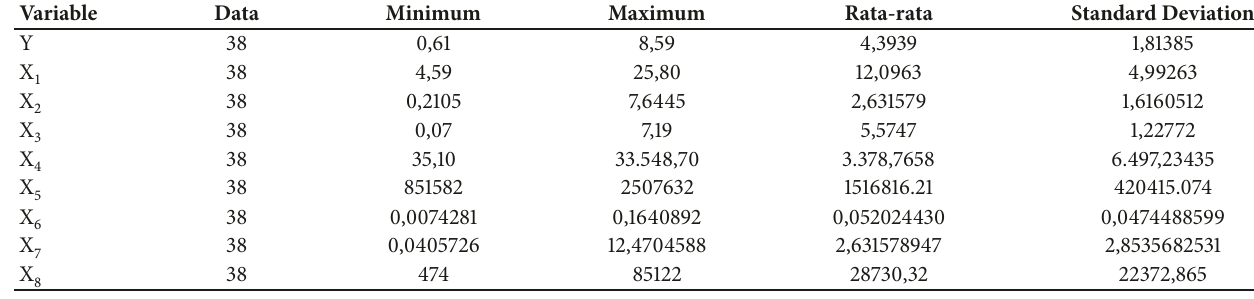
Table 1: Description of our research data and the predictor variables.